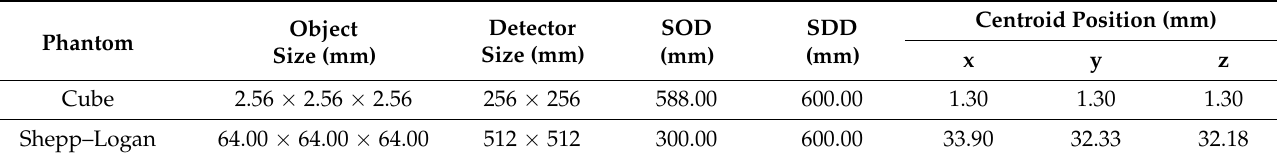
Table 2. Parameters of the simulation